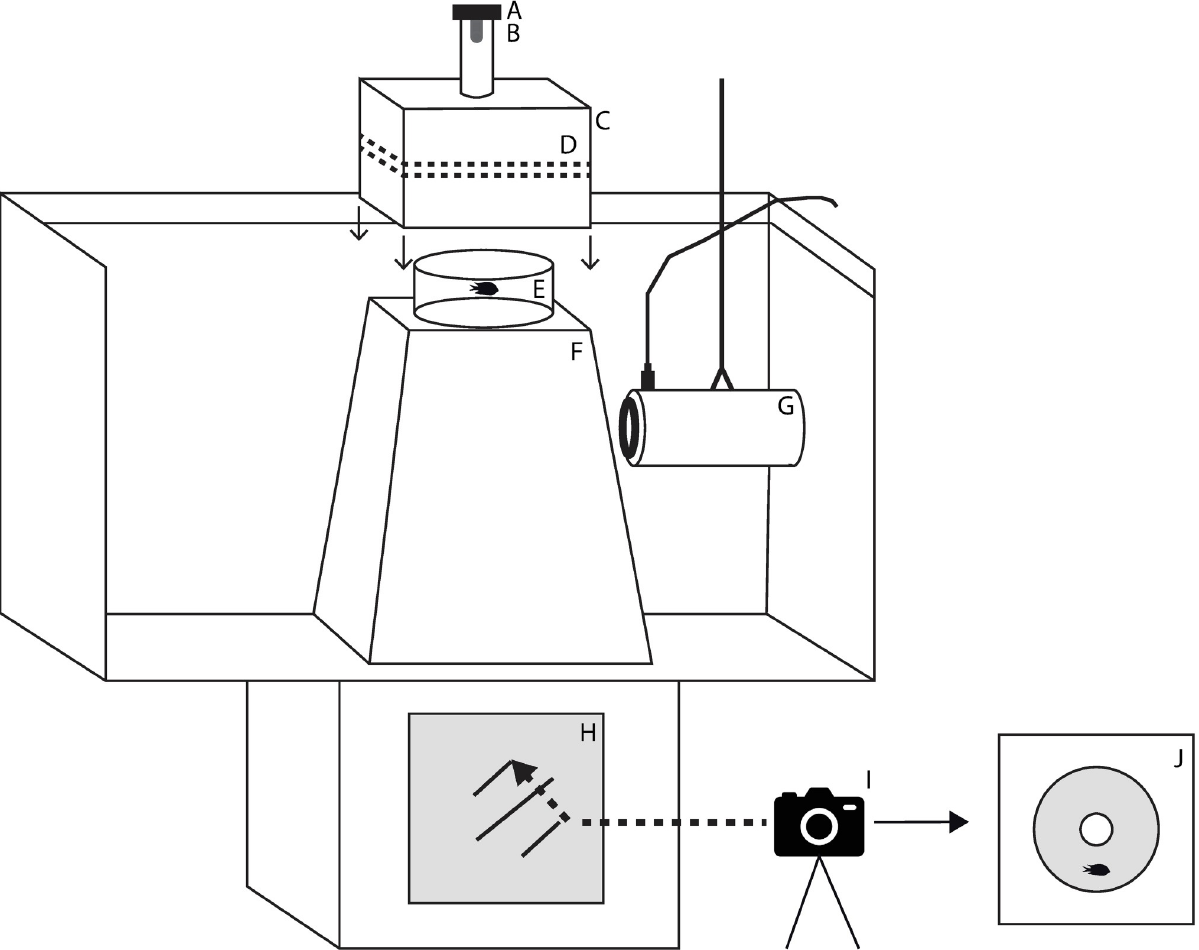
Fig 1. Schematic of the experimental set up. Experimental arena for analysis of routine swimming and escape response of Pomacentrus chrysurus . Electromagnet (A), tapered weight (B), opaque white container (C), LED lights (D), experimental arena (E), base of the experimental arena (F), J9 speaker (G), mirror (H), camera (I) and image projected from the mirror